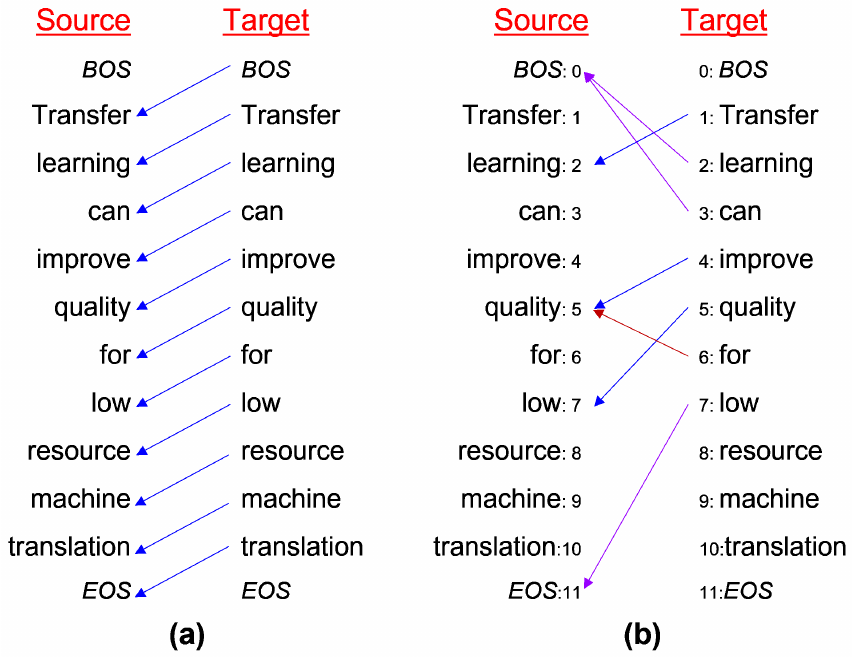
Figure 1. ( a ) Fixed cross-attention A fixed between the same sentence with monotonic increasing. E → E ( b ) cross-attentions that are non-aligned and aligned in the reverse